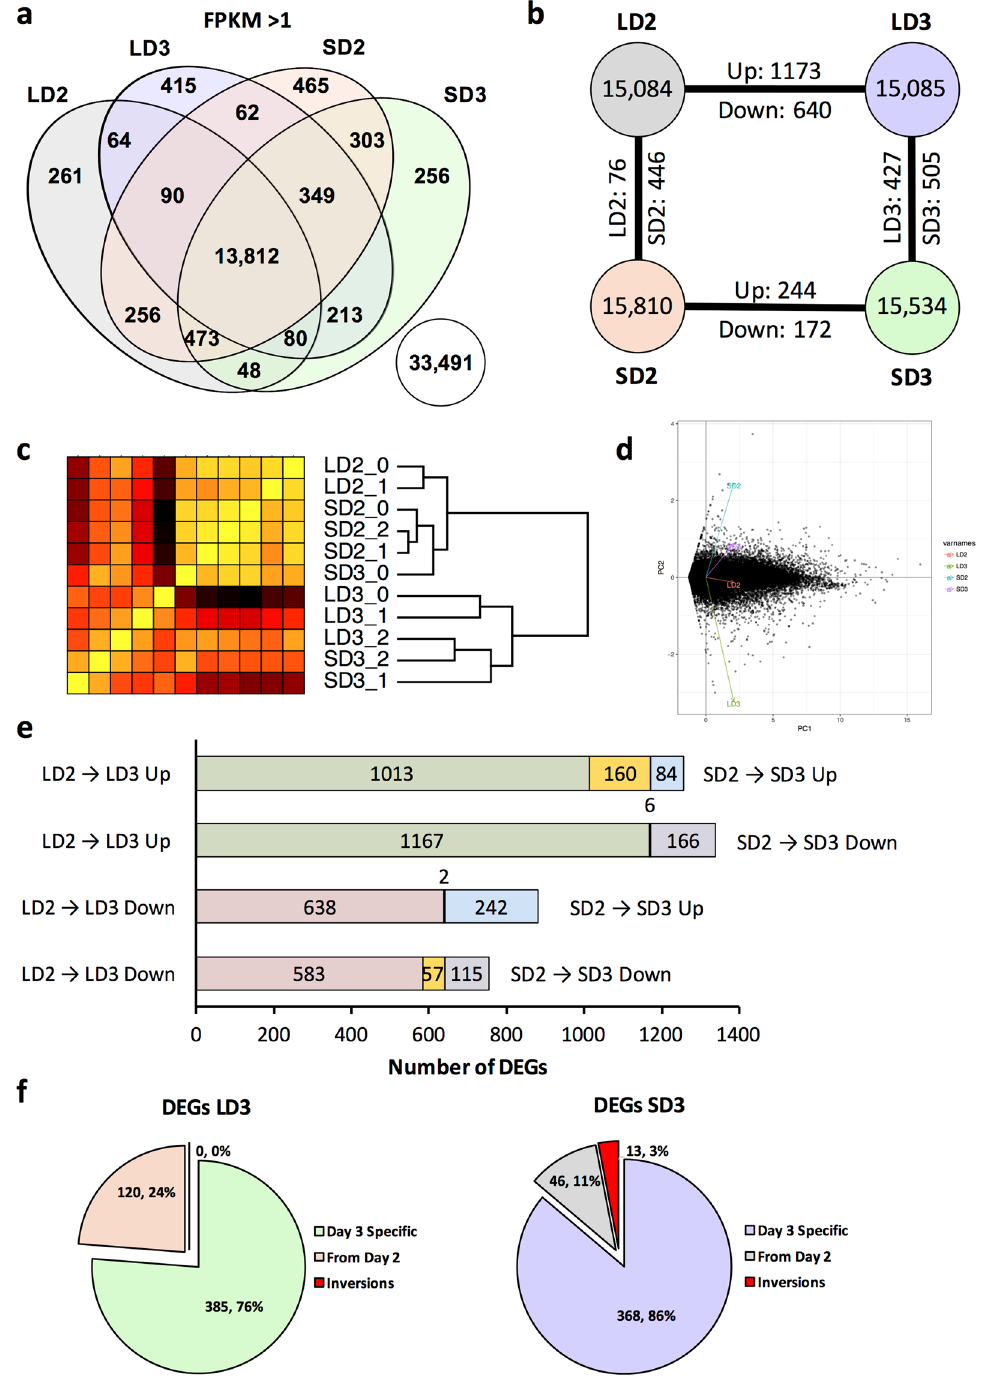
Figure 1. Profiles of murine transcripts during steroid and chemotherapeutic models of invasive pulmonary aspergillosis on day 2 and 3 post inoculation. Filtered, paired-end reads reads were analyzed by Cufflinks based pipeline. Transcripts with a FPKM greater than 1 were considered adequately expressed. ( a ) Venn diagram of murine transcript expression (FPKM > 1) between the two models. ( b ) Diagram of number of unique murine transcripts expressed and number of identified transcripts considered differentially expressed between the two models (FPKM > 1 in one of two comparators, log 2 -fold change > 1, and q < 0.05). ( c ) Hierarchical clustering and ( d ) principal component analysis of samples based on filtered gene expression. ( e ) Differentially expressed genes unique and conserved (yellow) between models from day 2 to day 3 post inoculation. ( f ) Composition of day 3 differentially expressed genes for a given model in respect to differential expression at day 2. Steroid Model, S; Chemotherapeutic Model, L; Day 2, D2; Day 3, D3; DEGS, differentially expressed